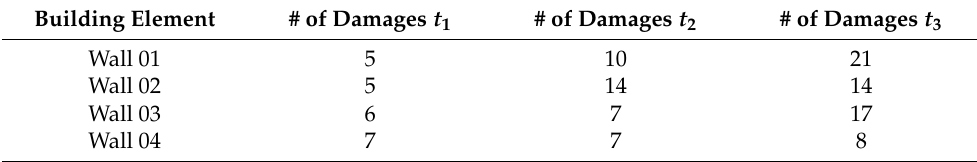
Table 1. Result of the damage assignment to the 3D model elements for each inspection.